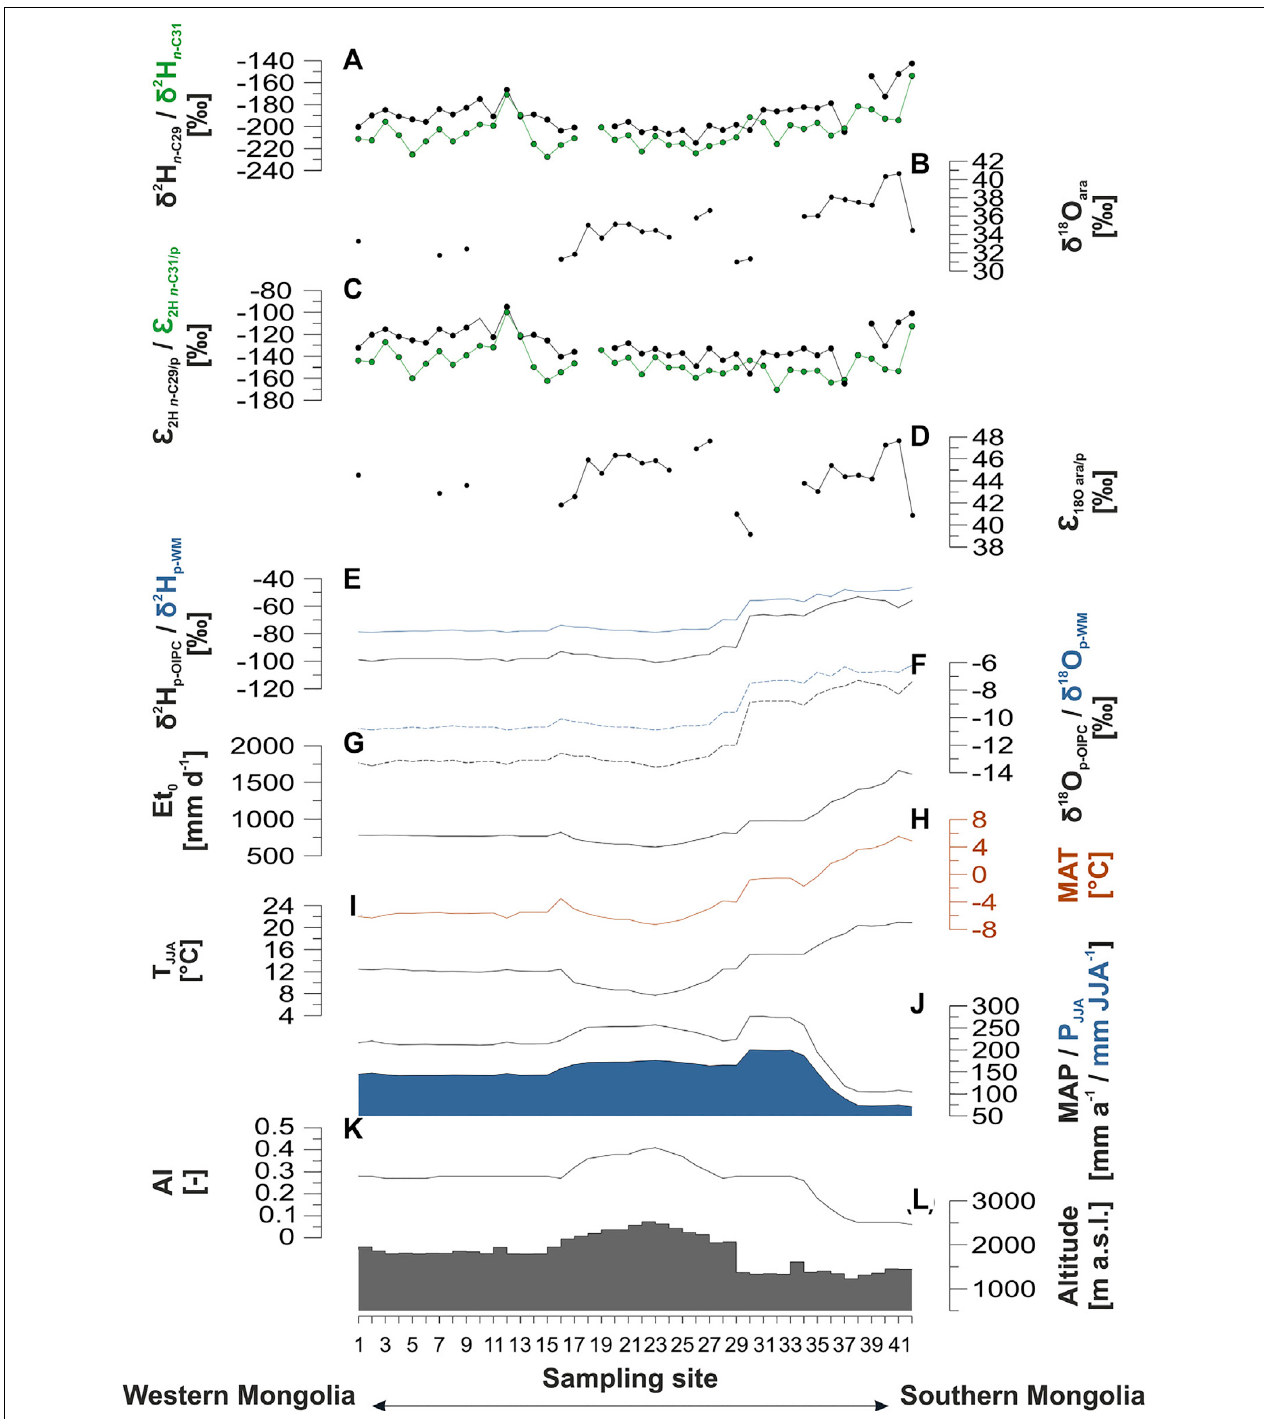
ε FIGURE 2 | δ 2 H and δ 18 O signatures of leaf wax-derived n -alkanes and the hemicellulose sugar arabinose as well as their apparent isotope fractionation ( app ), compared to environmental and climatic parameters along the transect. (A) Compound-specific δ 2 H of the leaf wax-derived n -alkane n -C 29 (black) and n -C 31 (green) ε ε ε (this study), (B) compound-specific δ 18 O ara (this study), (C) 2H n - C 29 / p (black) and 2H n - C 31 / p (green) (this study), (D) 18O ara / p (this study), (E,F) OIPC isotopic composition of precipitation (black line) and amount-weighted isotopic signature of precipitation (blue line): δ 2 H p (E) , and δ 18 O p (F) , respectively (Bowen et al., 2005; IAEA/WMO, 2015; Fick and Hijmans, 2017; Bowen, 2019), (G) the potential evapotranspiration (Et 0 ) (Trabucco and Zomer, 2019), (H) mean annual temperature (MAP) (Fick and Hijmans, 2017), (I) averaged summer temperature of June, July, and August (T JJA ), (J) black line shows the mean annual precipitation (MAP), blue shaded area the summer precipitation amount (P JJA ) (Fick and Hijmans, 2017), (K) the aridity index (AI) (Trabucco and Zomer, 2019), and (L) the altitude (Jarvis et al., 2008).